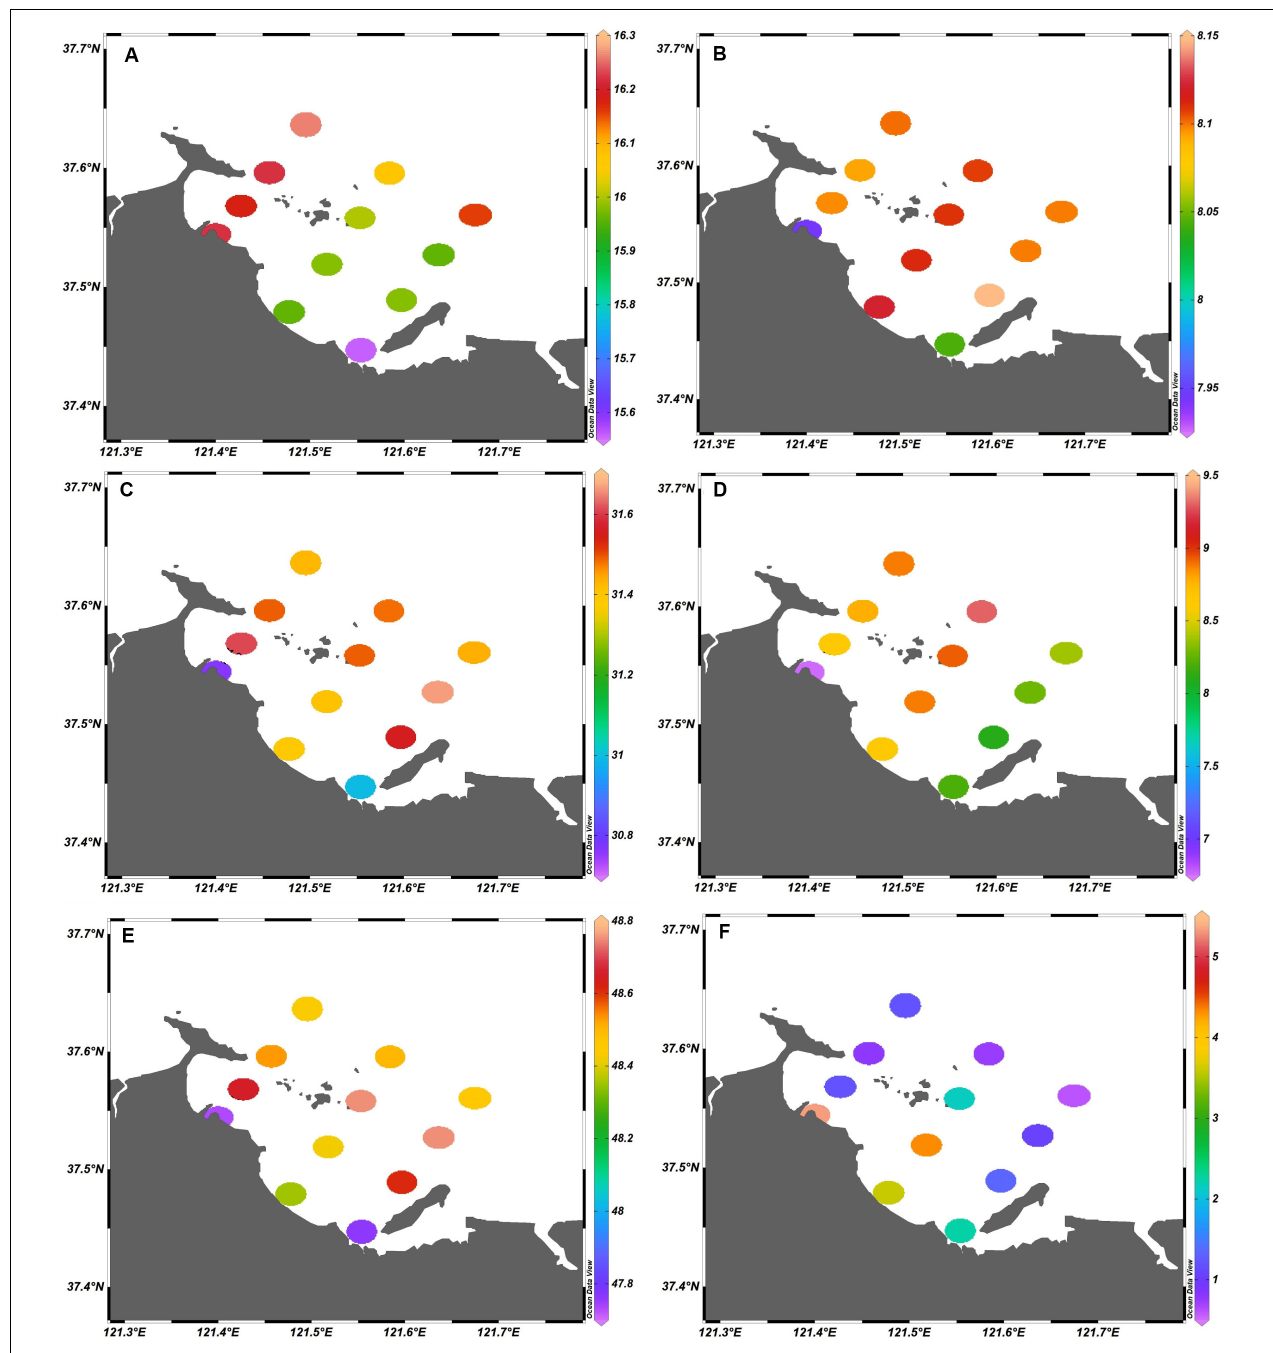
FIGURE 9 | Spatial distribution of physicochemical parameters (annual average values) in surface seawater of Sishili Bay. (A) Temperature ( ◦ C), (B) pH, (C) salinity, (D) dissolved oxygen (DO; mg/L), (E) conductivity ( µ S/cm), and (F) chlorophyll a ( µ g/L).